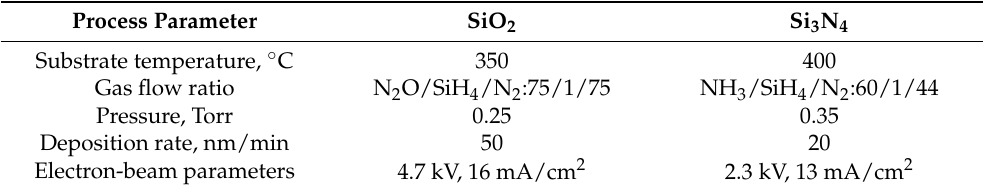
Table 1. Deposition parameters of silicon dioxide and nitride by the PECVD method.